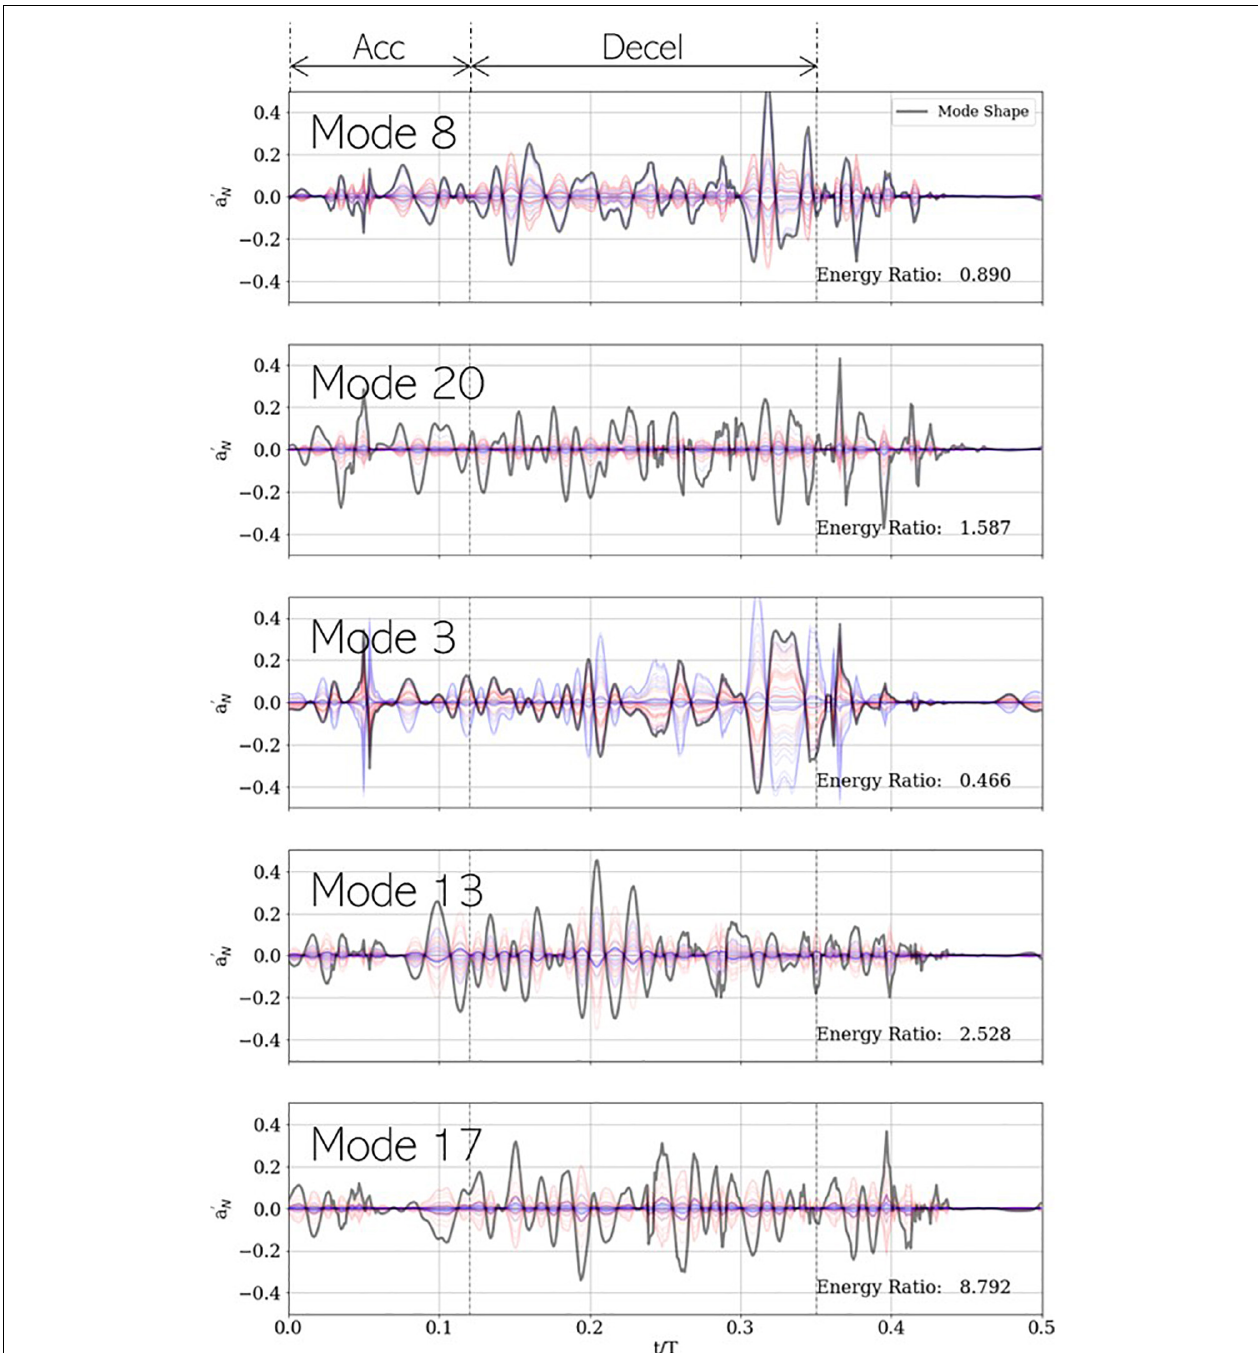
FIGURE 12 | Five most important PCA modes for LDA-based classification, shown with each mode shape (gray) and its corresponding contribution to the development dataset. Blue and red plots represent healthy and stenotic valves, respectively. Vertical dashed black lines at t / T = 0 . 12 and 0 . 35 indicate the ends of acceleration and deceleration phases of systolic ejection, respectively. For each mode, energy ratio is listed in the bottom-right corner of the corresponding